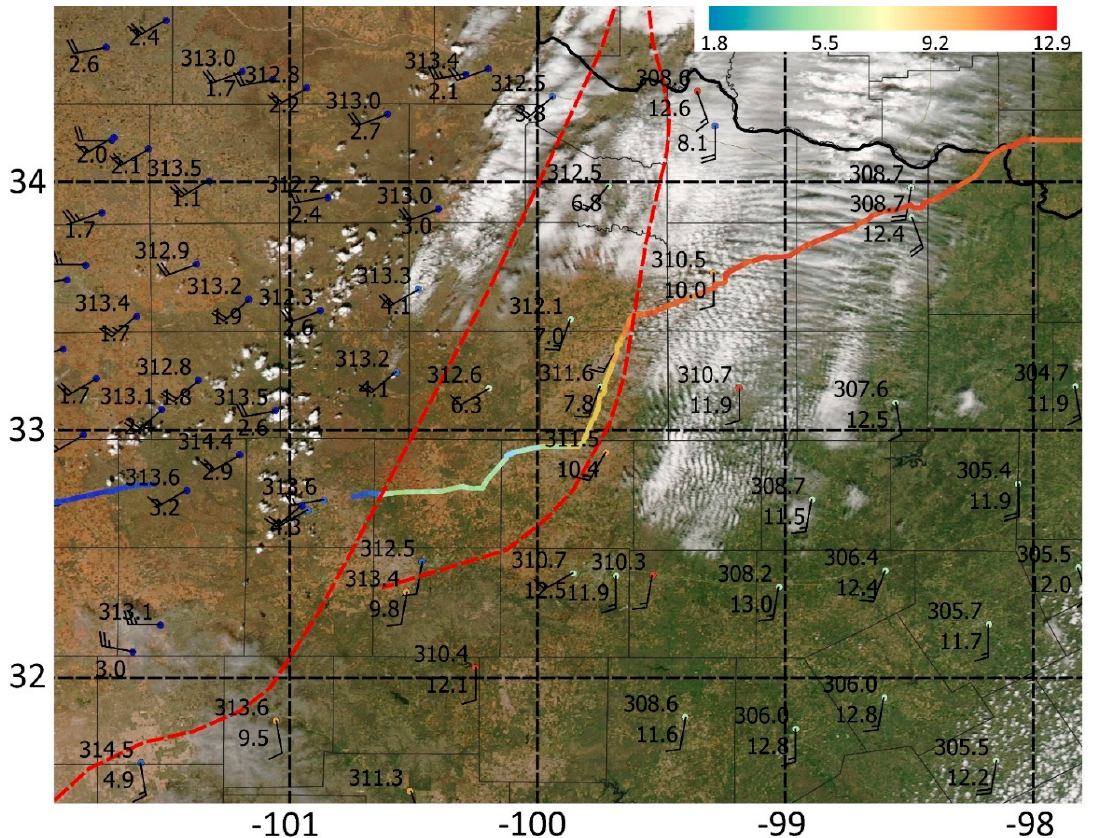
Figure 11. Mobile track of mixing ratio adjusted to 2135 UTC on 9 April 2017, with overlay of MODIS (moderate resolution imaging spectroradiometer) Aqua 250 m visible imagery at 2005 UTC (from [46]), surface station observations, and analyzed western and eastern dryline positions. Station observations of θ v , mixing ratio, and wind are at 2200 UTC from synoptic stations and 2135 UTC from mesonet stations.